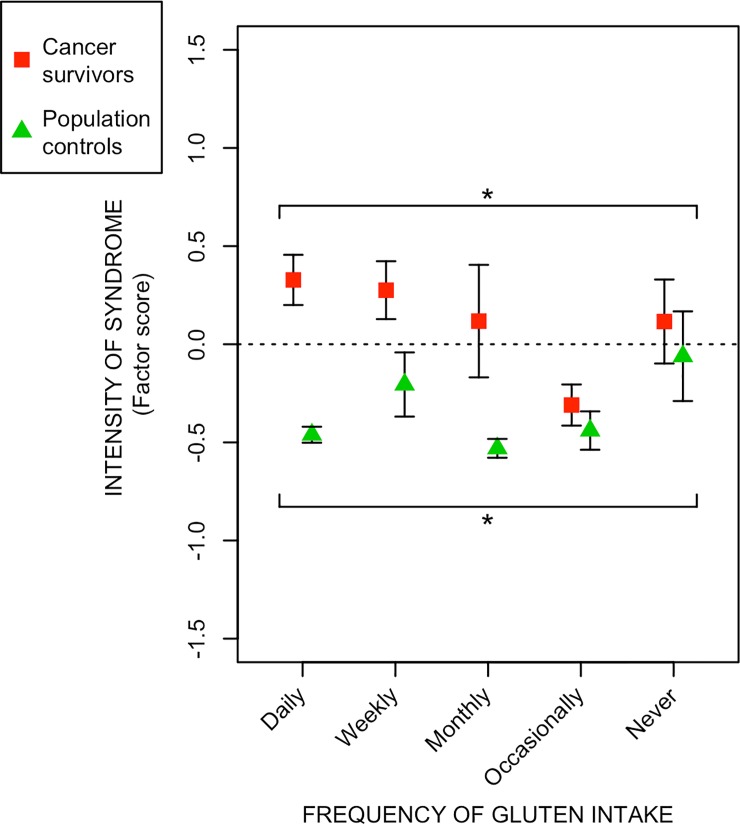
Relationship between intensity of excessive mucus discharge and frequency of gluten intake.The figure depicts the relationship between frequency of gluten intake (x-axis) and the intensity (factor scores) of the radiation induced syndrome (y-axis) excessive mucus discharge among long-term gynecological cancer survivors and population controls. Red squares/green triangles denote the mean syndrome intensity within certain gluten intake frequency levels. Vertical black lines stretch between plus-minus the standard error of the mean. Asterisks correspond to significance levels of the Spearman correlations between syndrome intensity and frequency of gluten intake according to: p ≤ 0.001 - ***, 0.001 < p ≤ 0.01 - **. 0.01 < p ≤ 0.05 - *. Estimates of the Spearman correlations are found in Tables 2 and 3.